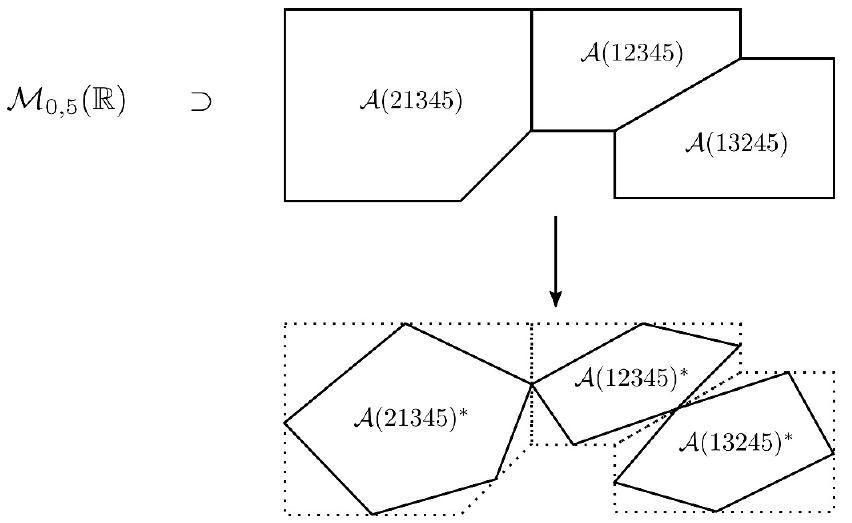
Figure 9 . A portion of M 0 ; 5 ( R ). By associating to every side of each pentagon a vertex of the dual pentagon, we arrive at a net of dual pentagons with shared vertices. Rearranging this net leads us to (cid:12)gure